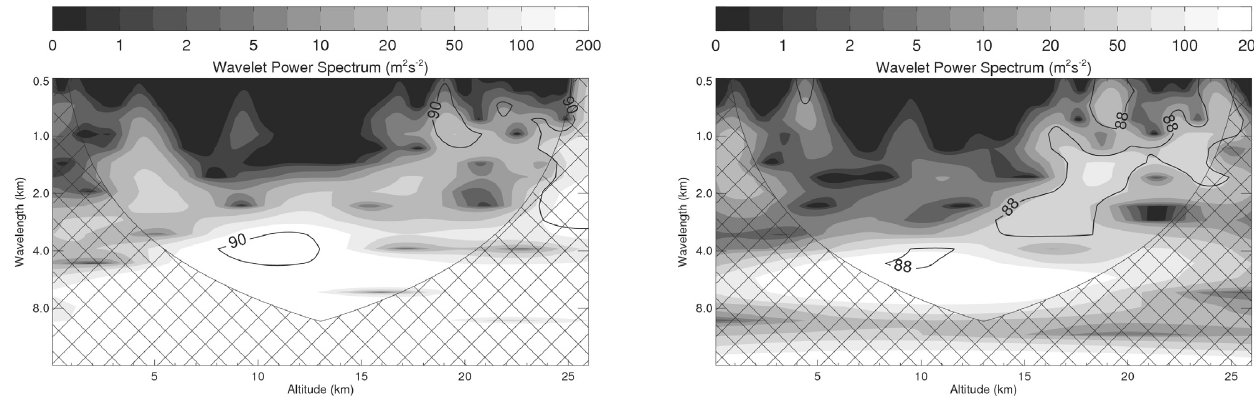
Fig. 2. Case 1: Santo Domingo radiosounding. Morlet wavelet analysis of the splined vertical velocity profiles by Torrence and Compo (1998) method. Power spectrum (m 2 s − 2 ) with level of significance above 90% (zonal component) and above 88% (meridional component) for dominant wavelengths and their locations. Hashed regions are out of the cone-of-significance, and should not be taken into account. Left: Zonal wind. Right: Meridional